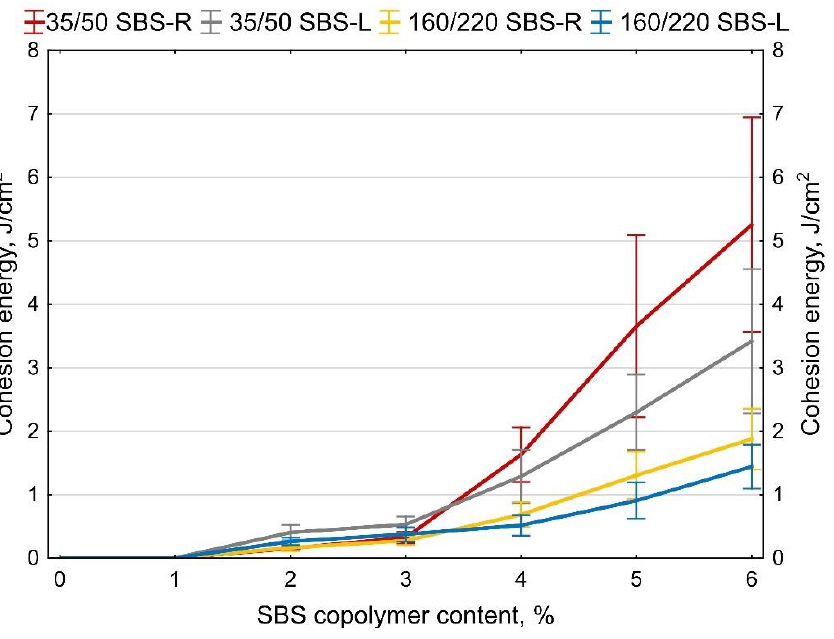
Figure 19. Cohesion energy of bitumen during stretching in Area III (as per Figure 2b), error bars show a 95% confidence interval for the mean.